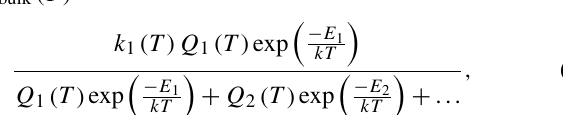
Figure 7. Theory-based k (298K) rate coefficients for cyclic RO 2 compared against the SAR predictions. The solid line shows 1 : 1 correspondence, with the dotted lines delineating an order of mag- nitude of